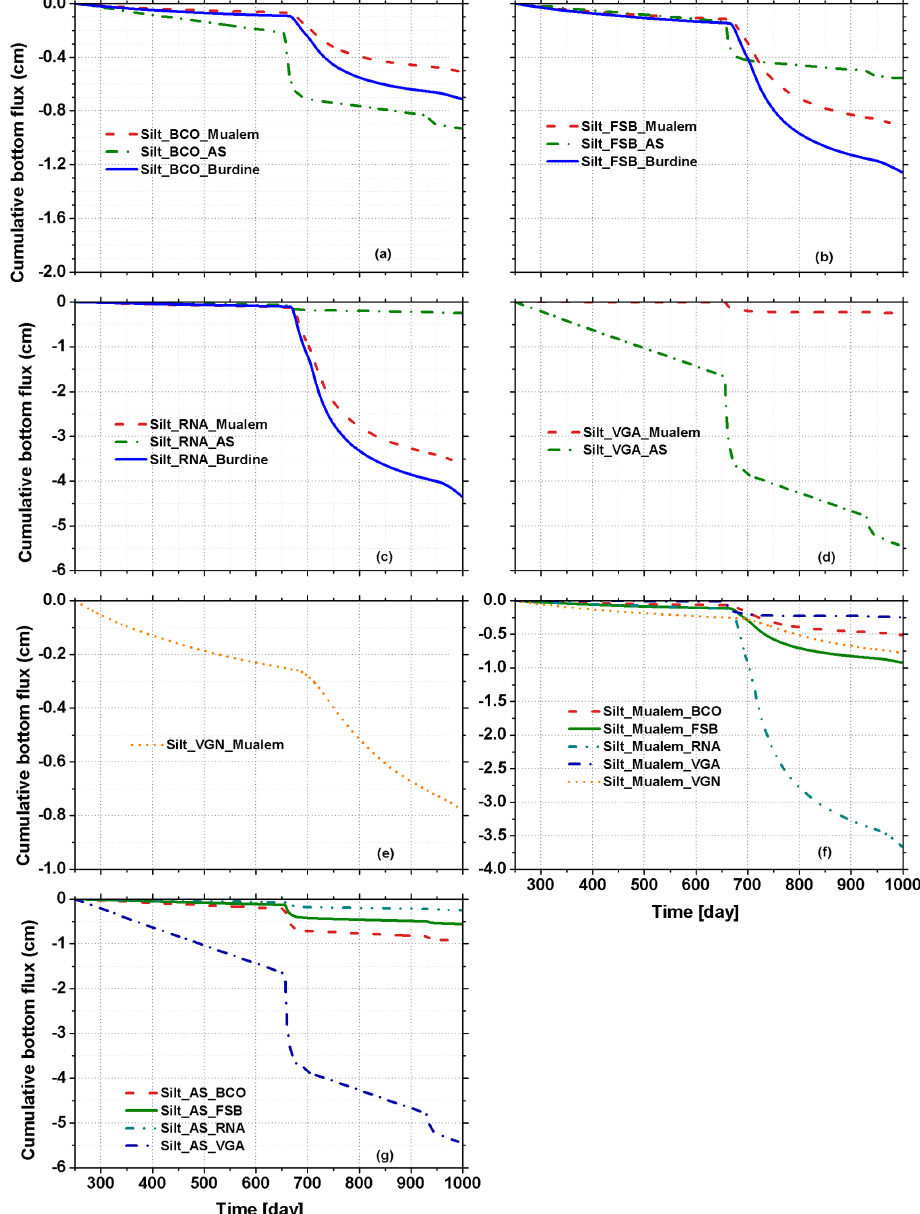
Figure 5. The cumulative bottom fluxes leaving a silt soil column for the different combinations of soil water retention curve and hydraulic conductivity parameterizations. Panels (a) through (e) present the results for the indicated retention parameterizations (see Table 1). Panels (f, g) organize the results according to the conductivity function: either Mualem (1976) (f) or Alexander and Skaggs (1986) (g)